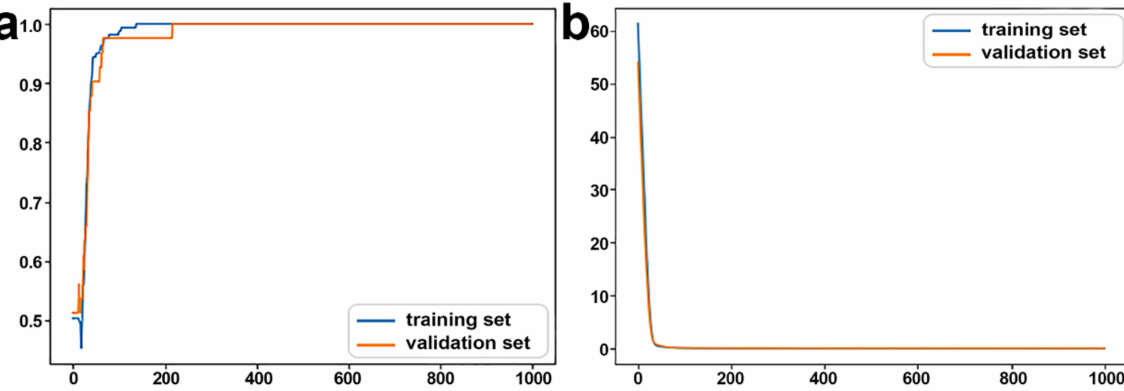
Figure 9. The accuracy and loss of the ceRNA DNN model for potential ceRNAs: ( a ) Accuracy curve and ( b ) loss